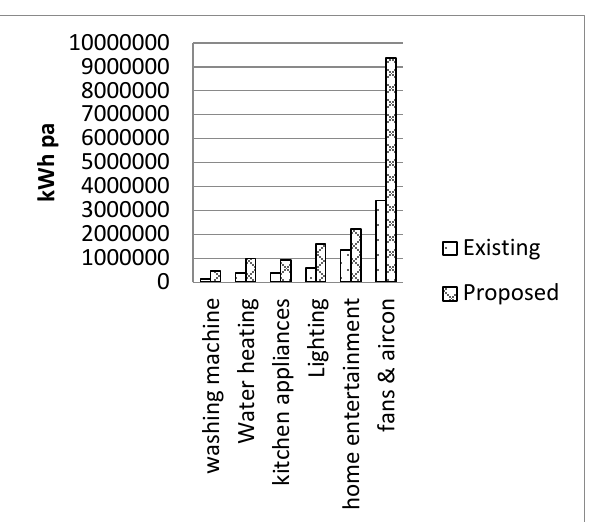
Figure 8. Comparison of residential electricity use.